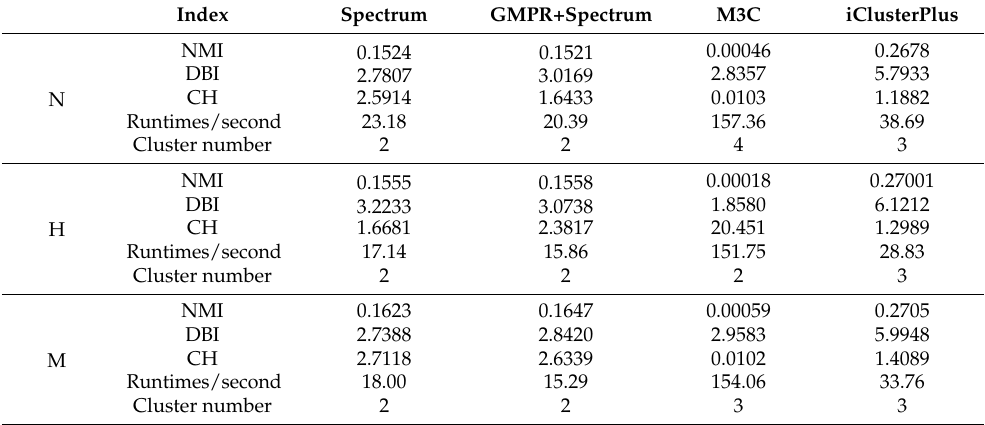
Table A2. Clustering evaluation indicators in N, H, M.